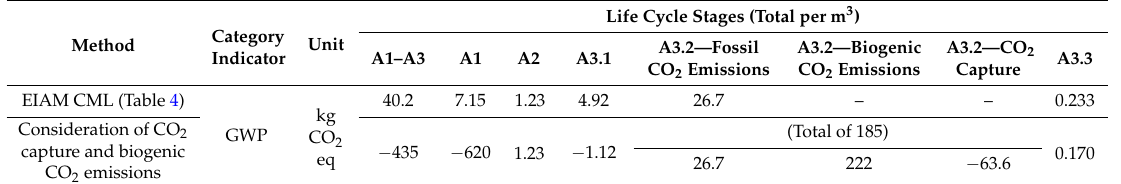
Table 6. GWP for each sub-stage of the “product stage” (A1–A3) of one cubic metre of ICB (with a density of 110 kg/m 3 ) —Comparison between CML and the consideration of CO 2 capture and biogenic CO 2 emissions. EIAM: Environmental Impact Assessment Method.